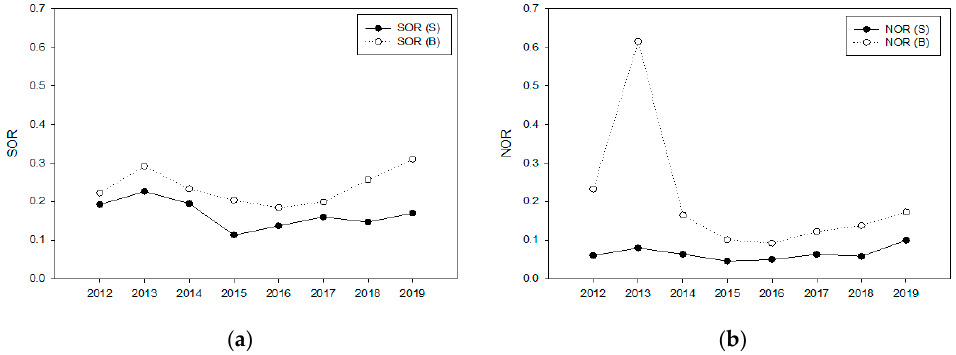
Figure 8. The changes in SOR and NOR in Seoul and Baengnyeong: ( a ) SOR; ( b ) NOR.